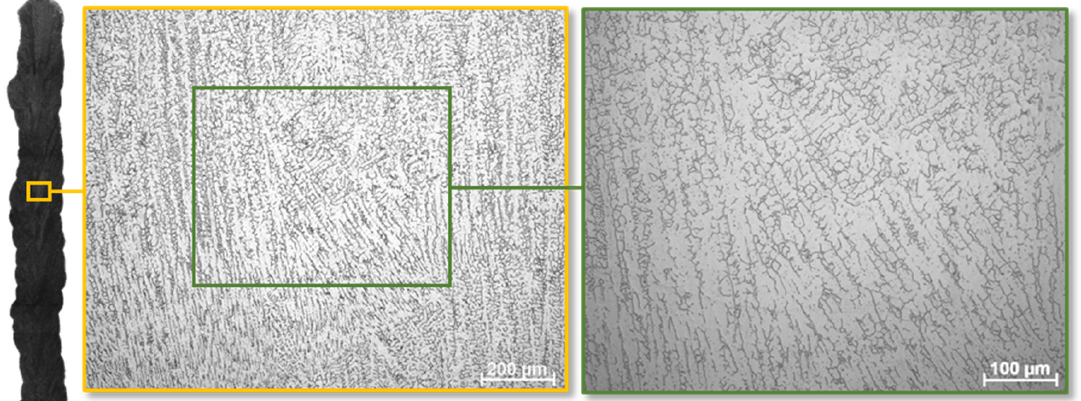
Figure 3. Microstructure of the WAAM component.